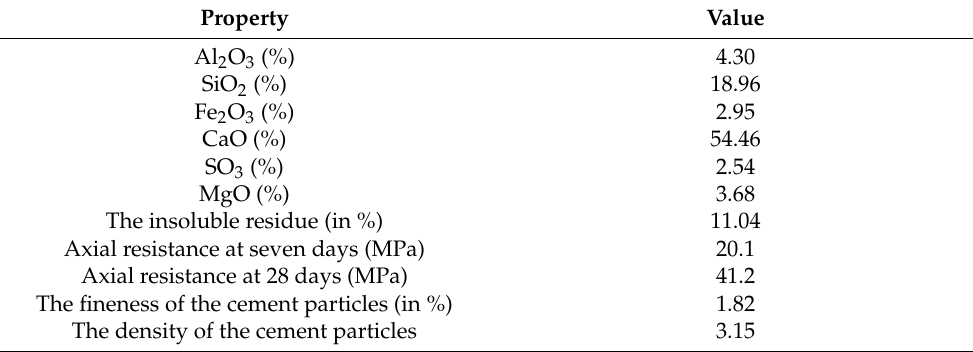
Table 3. Physical and chemical composition of the Portland cement sample.